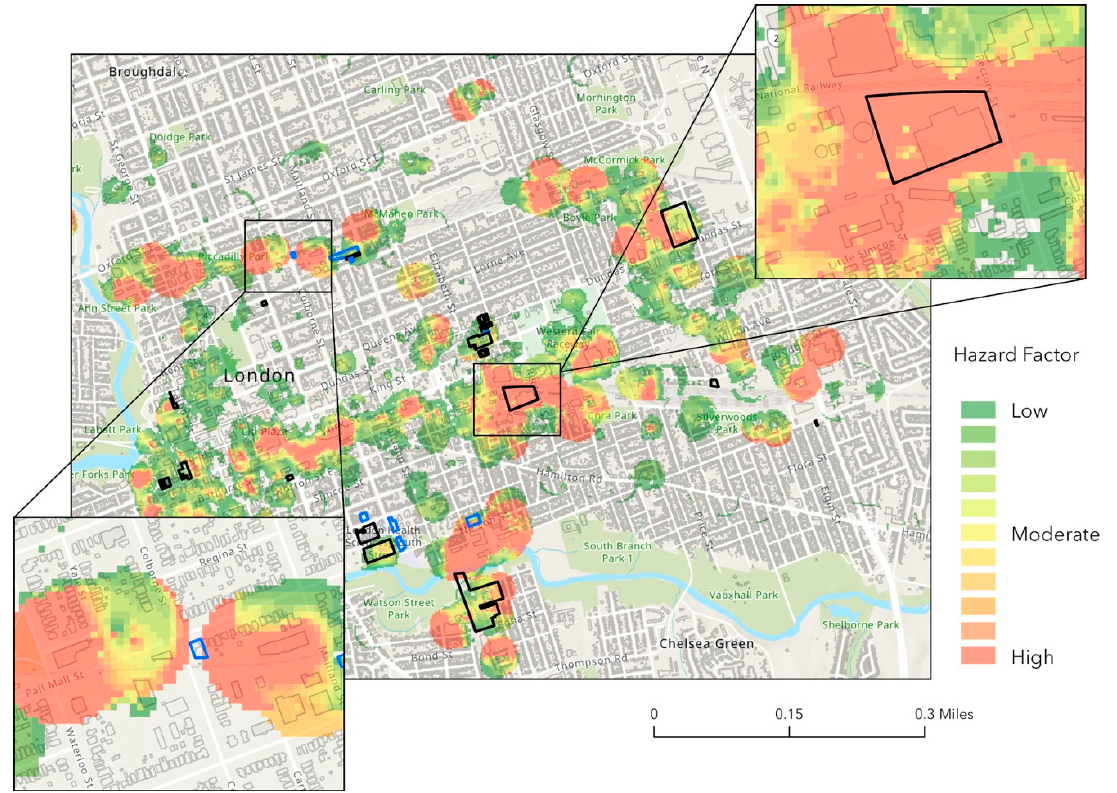
Figure 6. By summing the acute hazards recorded in multiple time periods, the London HSDI can be used to visualize the estimated accumulation of industrial hazards on a postindustrial landscape and highlight higher-risk hotspots. This predictive model can then be checked against real-world pollution testing data. In the image above, contaminated properties are outlined in black, while properties that were tested but did not contain contamination are outlined in blue. Image by author.